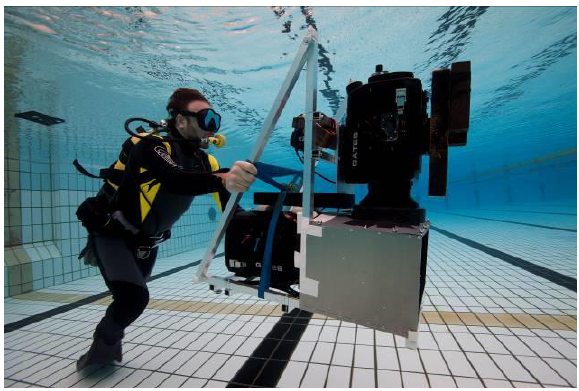
Figure 1. The first prototype: we were looking for using a wide angle on a beam splitter system. The idea was to use two housings equipped with dome and wide angle lens on a wet mirror box. The system was perfectly working in crystal clear waters. As soon as a particle was setting on the mirror, it was appearing only on one of the eyes. And this was destroying the possibility to use the